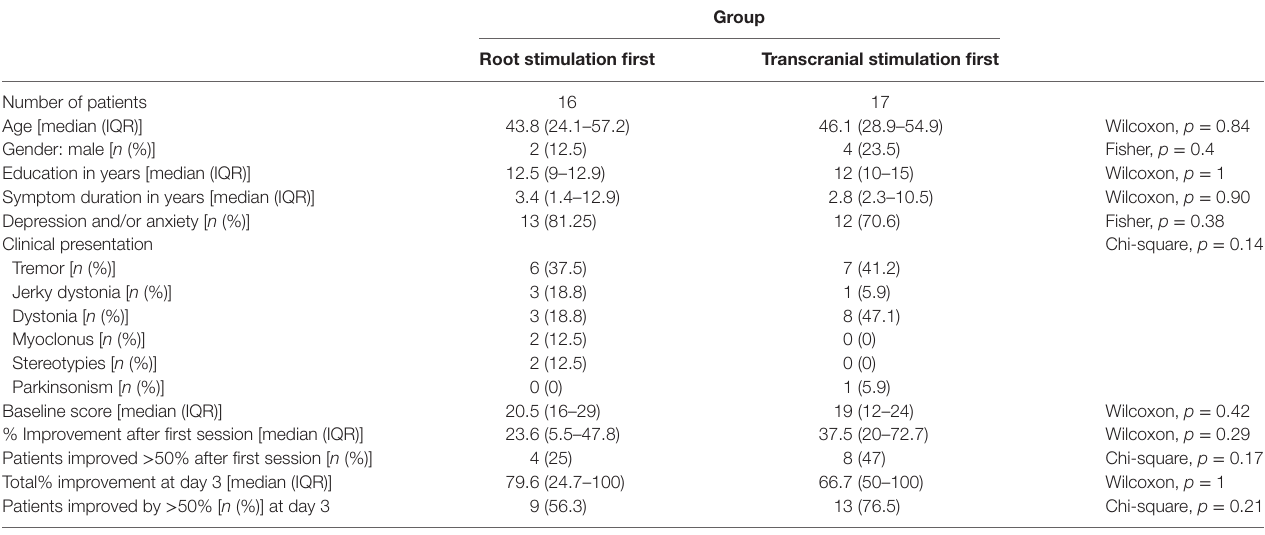
TaBle 2 | Comparison of the intervention